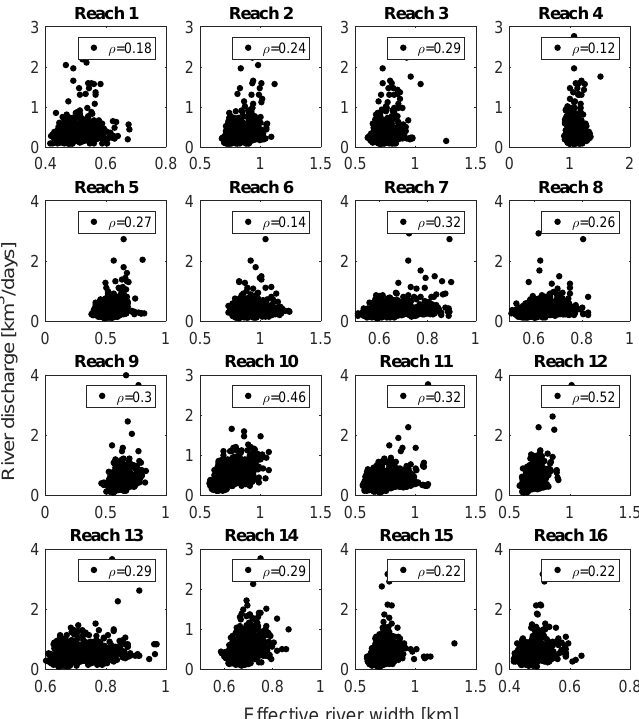
Figure A2. Comparison of effective river width and discharge at close-by gauging stations for 16 reaches along the Po